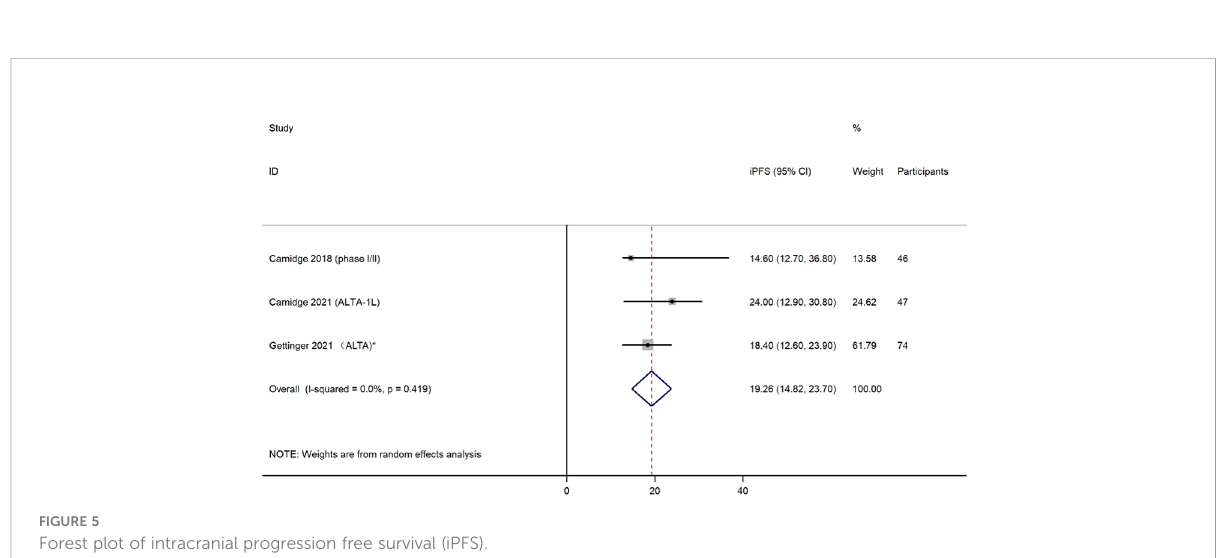
FIGURE 5 Forest plot of intracranial progression free survival (iPFS).